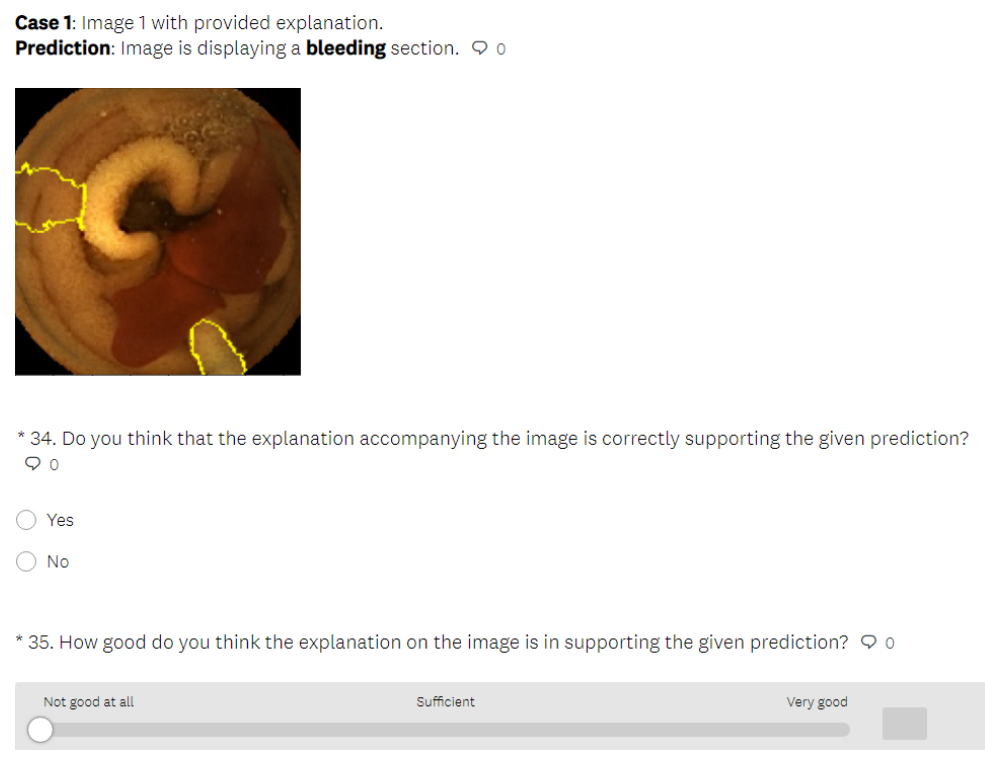
Figure 17. Incorrect LIME explanations in the user study.